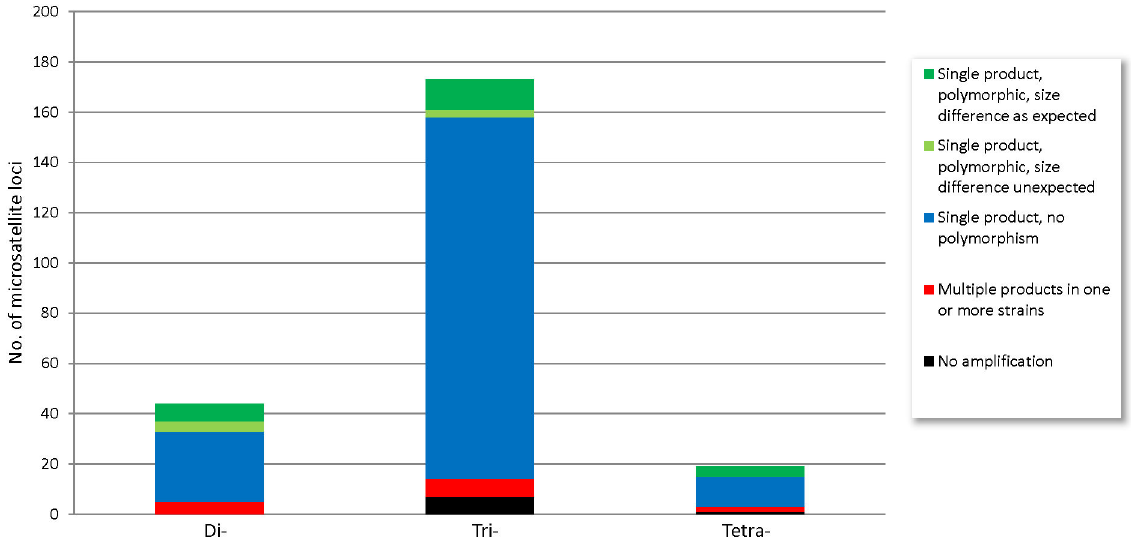
Figure 5. Experimental screening of microsatellite loci in Anisogramma anomala . For polymorphic loci, the expected size difference between alleles is multiples of the unit size (e.g. 2x, 3x, and 4x for di-, tri- and tetra- nucleotide motifs, respectively), assuming the motifs are perfect and there are no size differences in the flanking